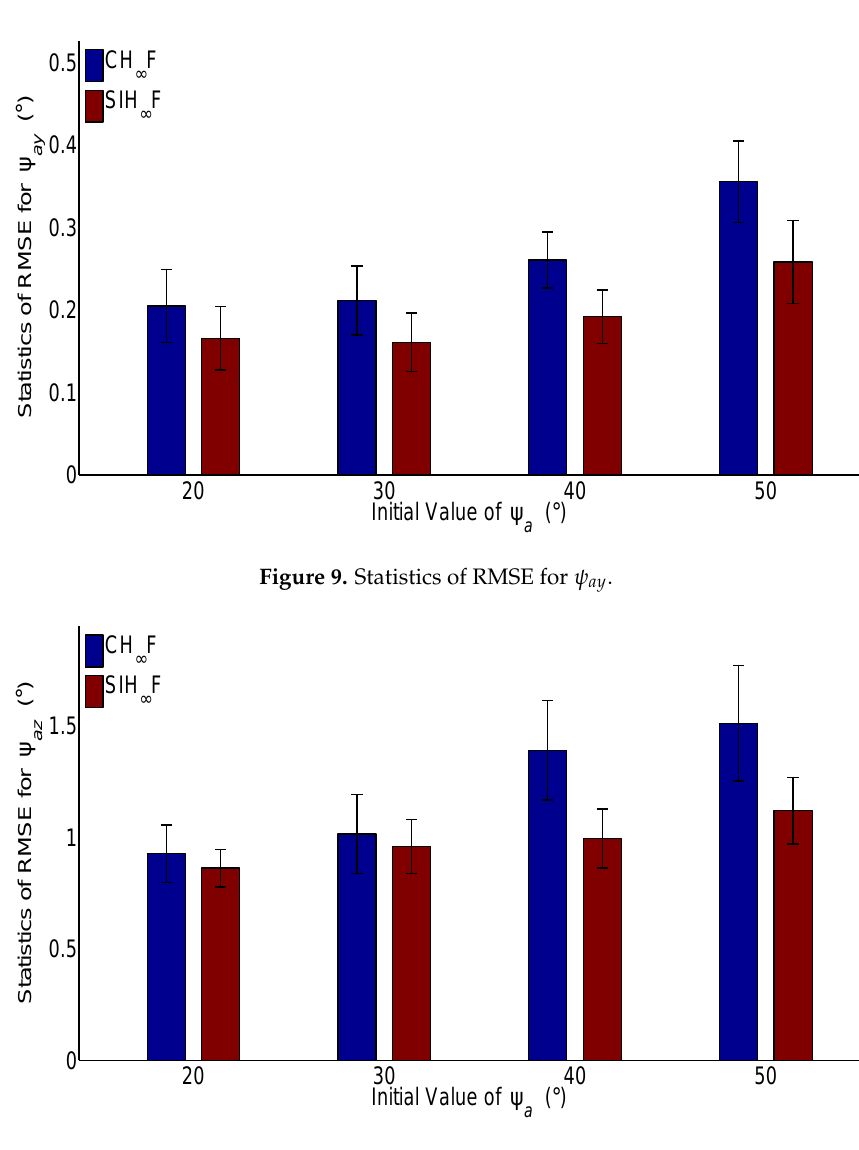
Figure 10. Statistics of RMSE for ψ az